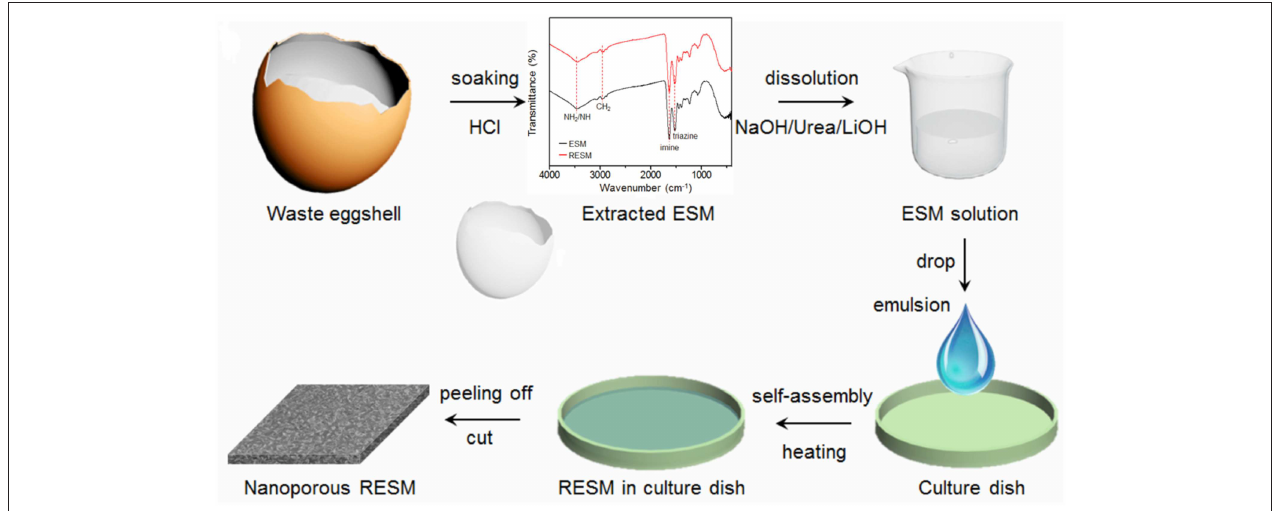
FIGURE 4 | Preparation of the ESM separator. Reprinted from Ma et al. (2018). Copyright (2018), with permission from